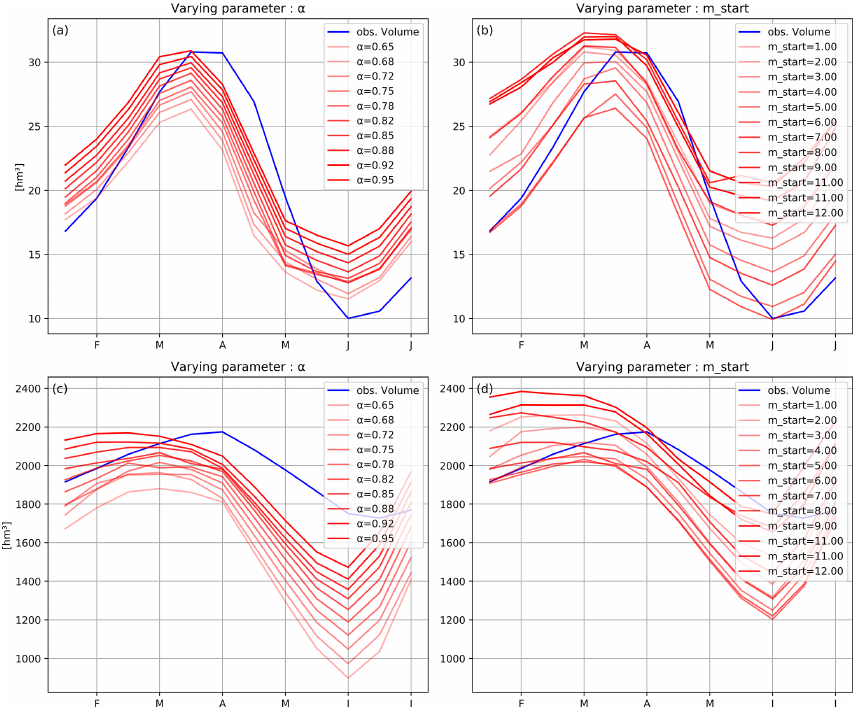
Figure 15. Example of seasonal pattern sensitivity of Gonzalez Lacasa (a, b) and Alcantara II (c, d) reservoir volumes to two of the DROP model parameters: (a, c) α and (b, d) m start . The remaining parameters were set at default values (see Table